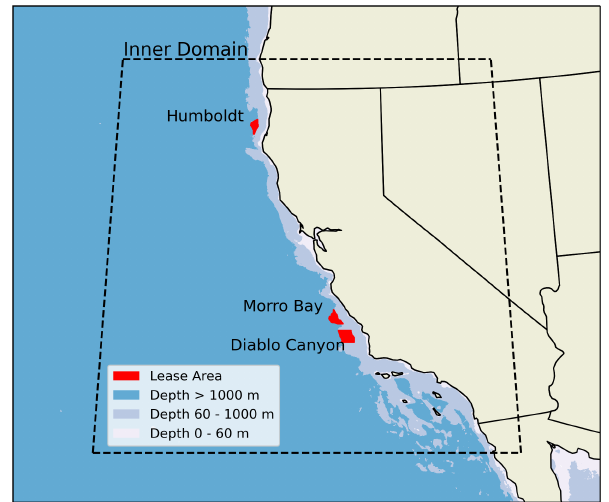
Figure 1. Map of the inner domain of the WRF numerical simula- tions for the California OCS. The current three wind energy lease areas are shown in